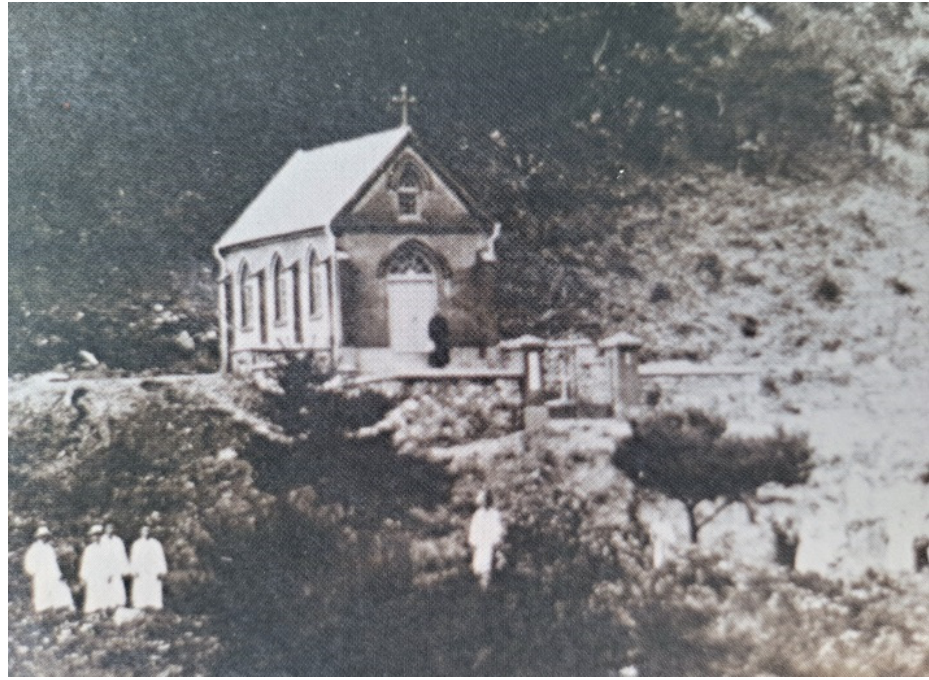
Figure 9. Image in 1928 [source: Father Mark Kang Do-Young’s Collection of Letters , p. 568].